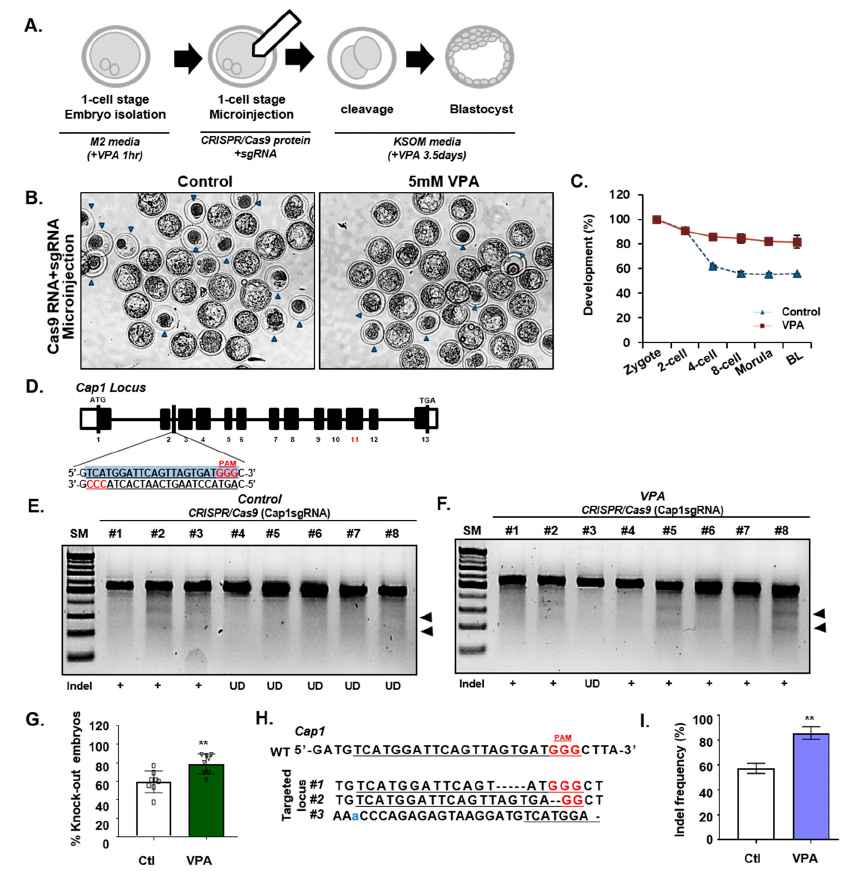
Figure 2. VPA enhances CRISPR / Cas9-mediated knock-out e ffi ciency in mouse embryos. ( A ) Schematic representation of CRISPR / Cas9 targeting in mouse embryos. Fertilized zygotes were cultured in M2 media, with or without VPA treatment for an hour, and microinjected with pre-assembled CRISPR / Cas9 RNP complexes. Afterward, the zygotes were cultured in KSOM media, with or without VPA for 3.5 days. ( B ) Images of the control or VPA-treated (5 mM) mouse blastocysts. Blue arrows indicate the embryos that failed to form blastocysts. ( C ) Percentage of viable mouse embryos in the control or VPA-treated groups at each developmental stage. ( D ) Schematic illustration depicting the targeting strategy for Cap1 locus. The targeting sequence is underlined, and PAM sequence is in red font. ( E , F ) The Surveyor assay for the InDel mutations induced by Cap1sgRNA ( E ) without or ( F ) with VPA-treatment in mouse embryos. The arrow indicates Surveyor-nuclease–digested PCR products. ( G ) The knock-out e ffi ciency, without or with VPA-treatment. Data were expressed as mean ± SD, n = 3. ** p < 0.01, two-sided Student’s t -test. ( H ) Sanger sequencing analysis of the Cap1 locus in the embryos CRISPR / Cas9-targeted, with or without VPA-treatment. The sgRNA sequence is underlined, and PAM sequence is in red font. ( I ) The InDel frequencies in Cap1 determined by Sanger sequencing in mouse embryos CRISPR / Cas9-targeted, without or with VPA-treatment. Data were expressed as mean ± SD, n = 3. ** p < 0.01, two-sided Student’s t -test. The images in B, E, and F are each representatives of ≥ 3 similar